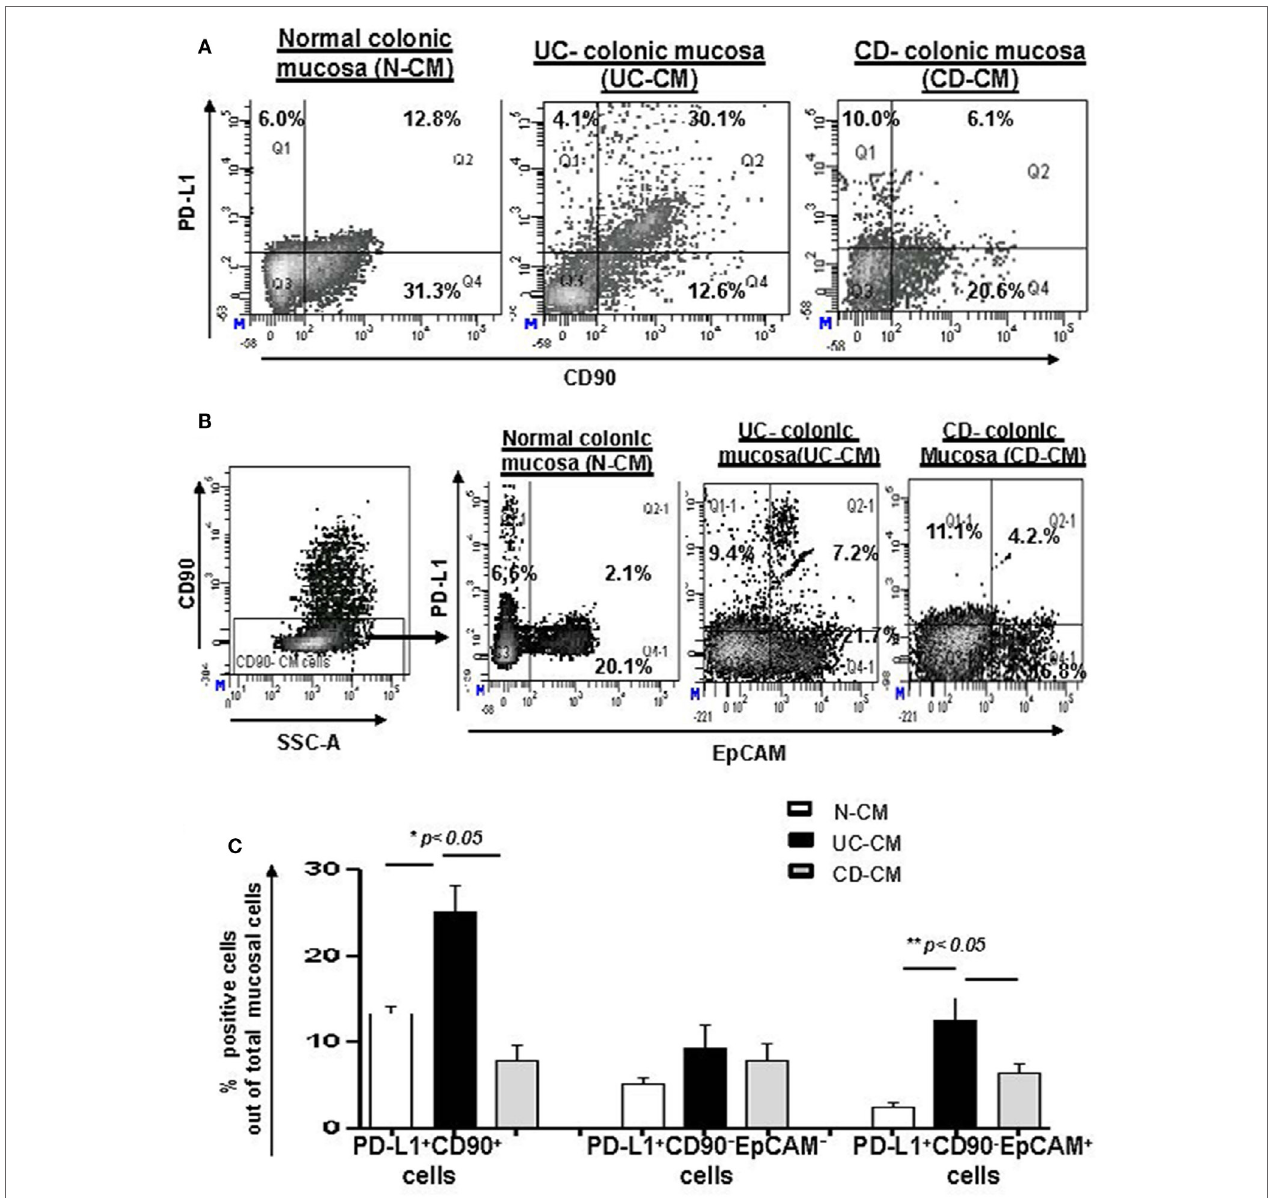
FigUre 2 | The number of programmed death-ligand 1 (PD-L1) expressing CD90 + colonic stromal cells (CMFs) is increased in ulcerative colitis (UC), but decreased in Crohn’s disease (CD) colitis. Freshly digested Normal (N), UC, and CD colonic mucosal single cell suspensions (CM) were prepared and immunostained and analyzed by multi-color flow cytometry. Live events were gated and mucosal cells (CMs) were analyzed for the PD-L1 expression. (a) A representative density plot for the flow cytometry analysis for the expression of PD-L1 by CD90 + CMFs. (B) A representative density plot for the flow cytometry analysis for the expression of PD-L1 by EPCAM + cells out of CD90 − colonic mucosal (CD90 − CM) cells. (c) Summary of the PD-L1 expression by CD90 + EpCAM − cells (CMFs) CD90 − EpCAM + cells (epithelial cells) and CD90 − EpCAM − professional immune cells in normal, UC-CM, and CD-CM preparations (flow cytometry analysis). Values are expressed as a mean of percentage positive cells ± SD, n = 9 per group.